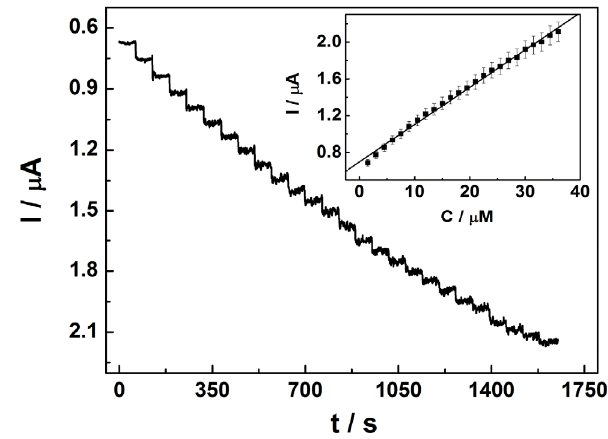
Figure 4. Amperometric responses at the CTAB/CP electrode at a constant potential of 0.95 V in 10 mL PBS (pH 7.0) with injection of 1.5 μ M NP every 60 s. The inset is a plot of the oxidation peak current against the concentration of NP (from 1.5 to 36 μ